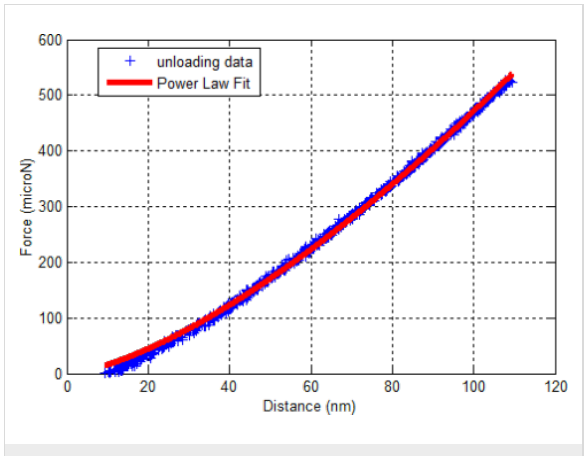
Figure 14: Power-law fitting to the unloading part of a silicon force–distance curve.